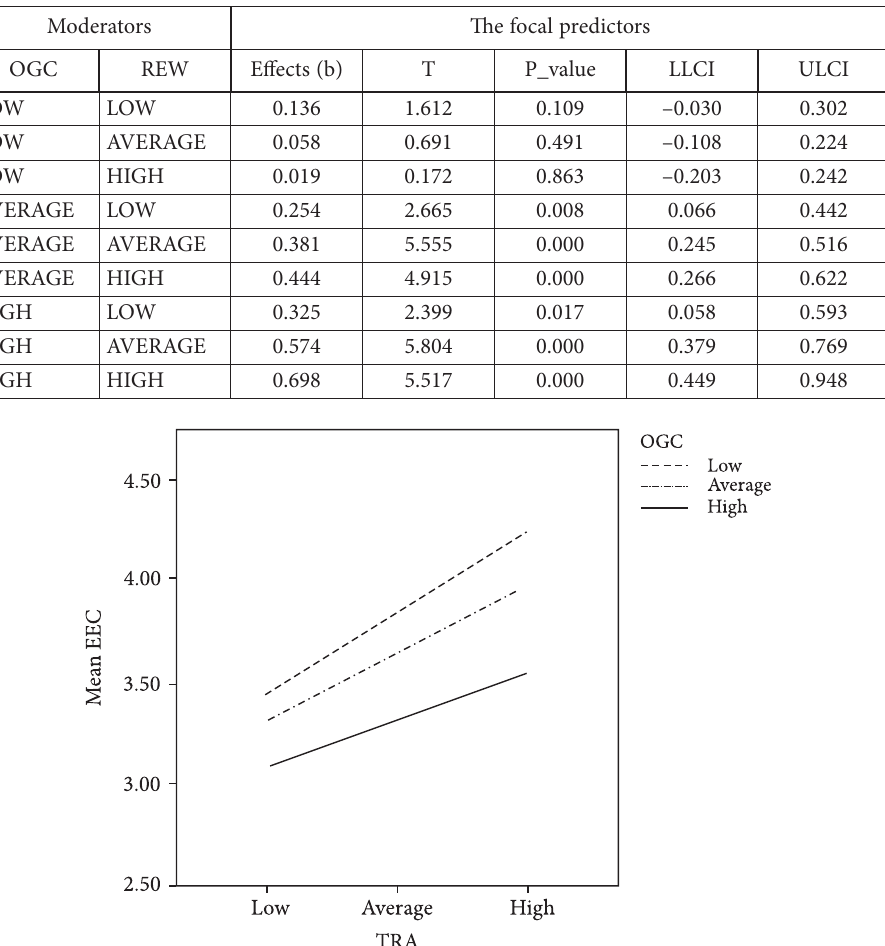
Table 6. Conditional effects at values of OGC and REW